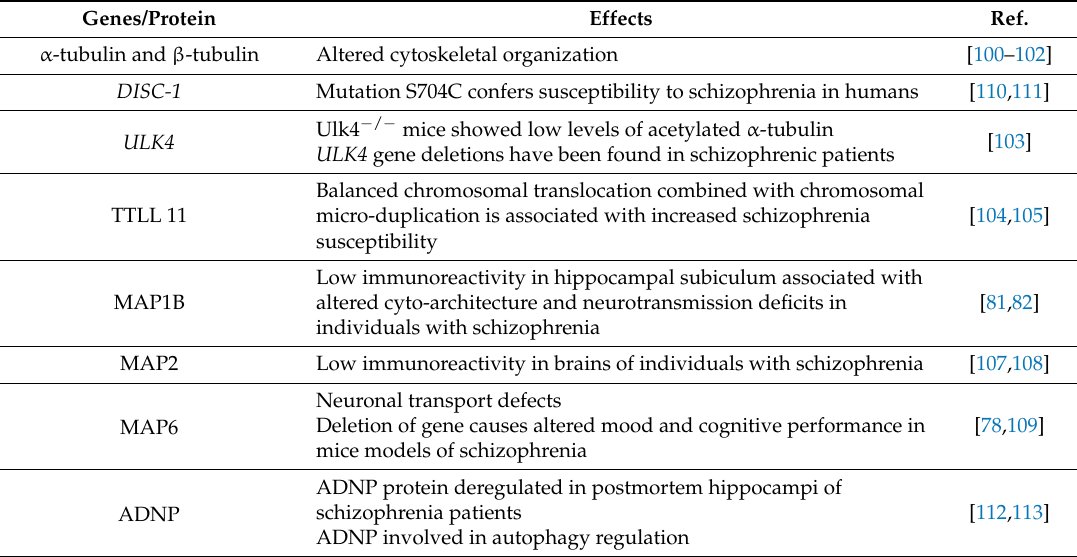
Table 2. MTs and MTs regulatory protein and gene alterations associated with